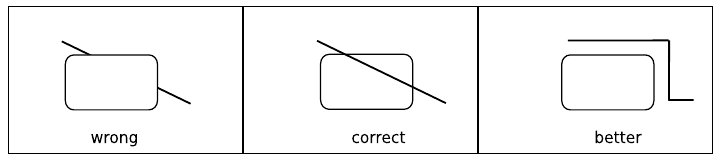
Figure 4.2: If an edge crosses a node, the edge must be drawn on top of the